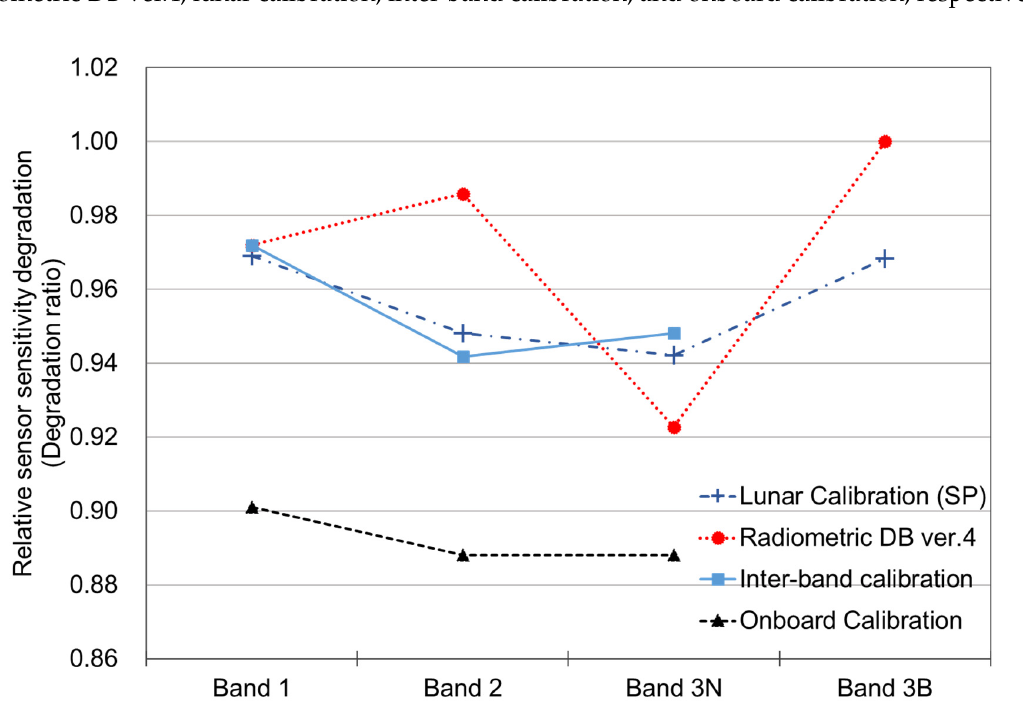
Figure 3. Comparison of the relative sensor sensitivity degradation (RD) in ASTER-VNIR bands from 2003 to 2017 derived from the RCCs in the radiometric DB ver. 4 and three different calibration methods (i.e., lunar, inter-band, and onboard calibrations) [6].